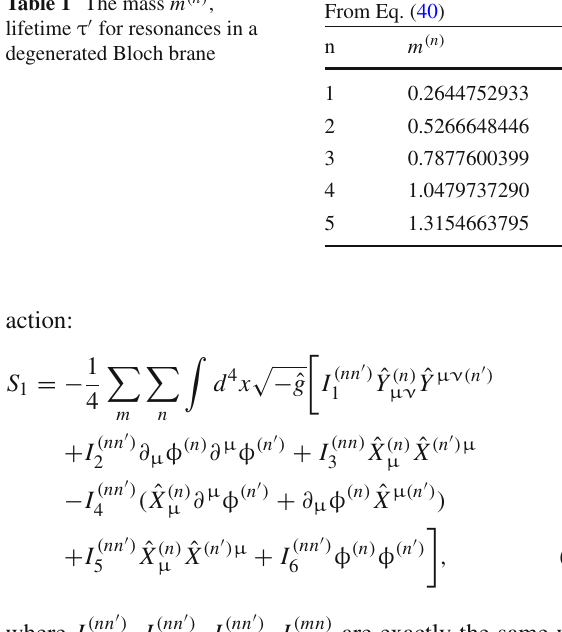
Table 1 The mass m ( n ) , lifetime τ (cid:3) for resonances in a degenerated Bloch brane